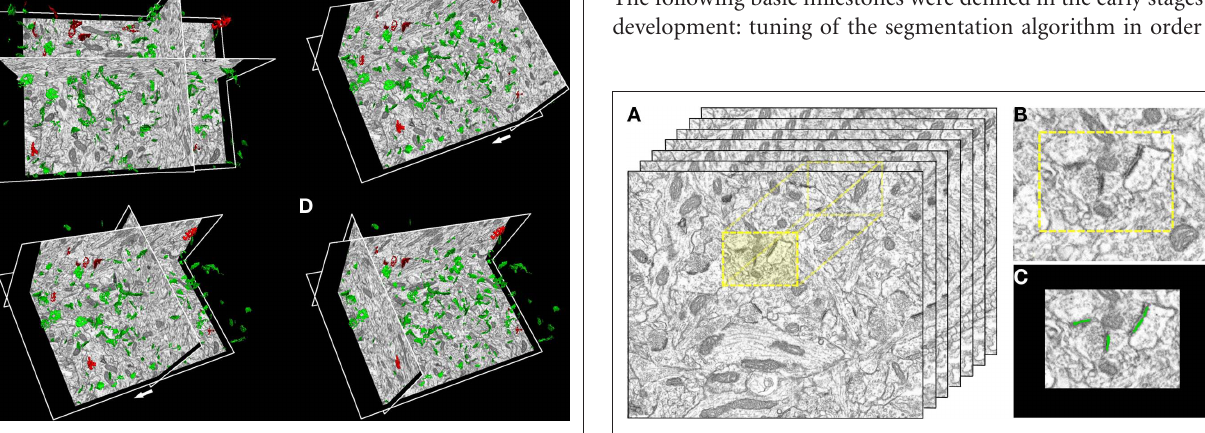
Figure 4 | (A) 3D reconstruction of the segmented synaptic junctions in a stack. (B–D) The user can modify the position of any plane to visualize the 3D reconstructed objects. In this example, one plane has been displaced (following the direction of the arrow) to show different views. Green objects represent asymmetric synaptic profiles and red objects symmetric synaptic